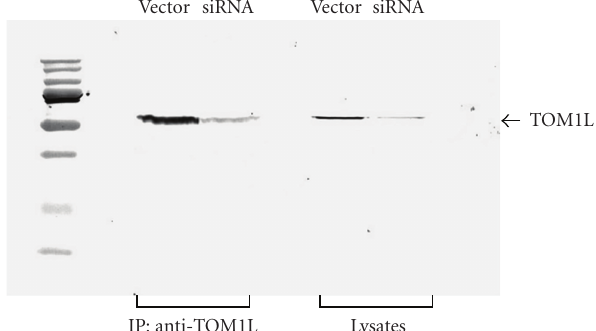
Figure 6: The protein expression of TOM1L in whole lysates and immunoprecipitated lysates (anti-TOM1L antibodies) examined by western blot analysis in Jurkat cells after siRNA treatment. The siRNA experiments were performed by lenti virus-mediated infection of a hairpin construct. The expression of TOM1L was e ffi ciently reduced in cells infected with the hairpin construct (siRNA) as compared with cells infected with a vector lacking the hairpin construct (Vector).